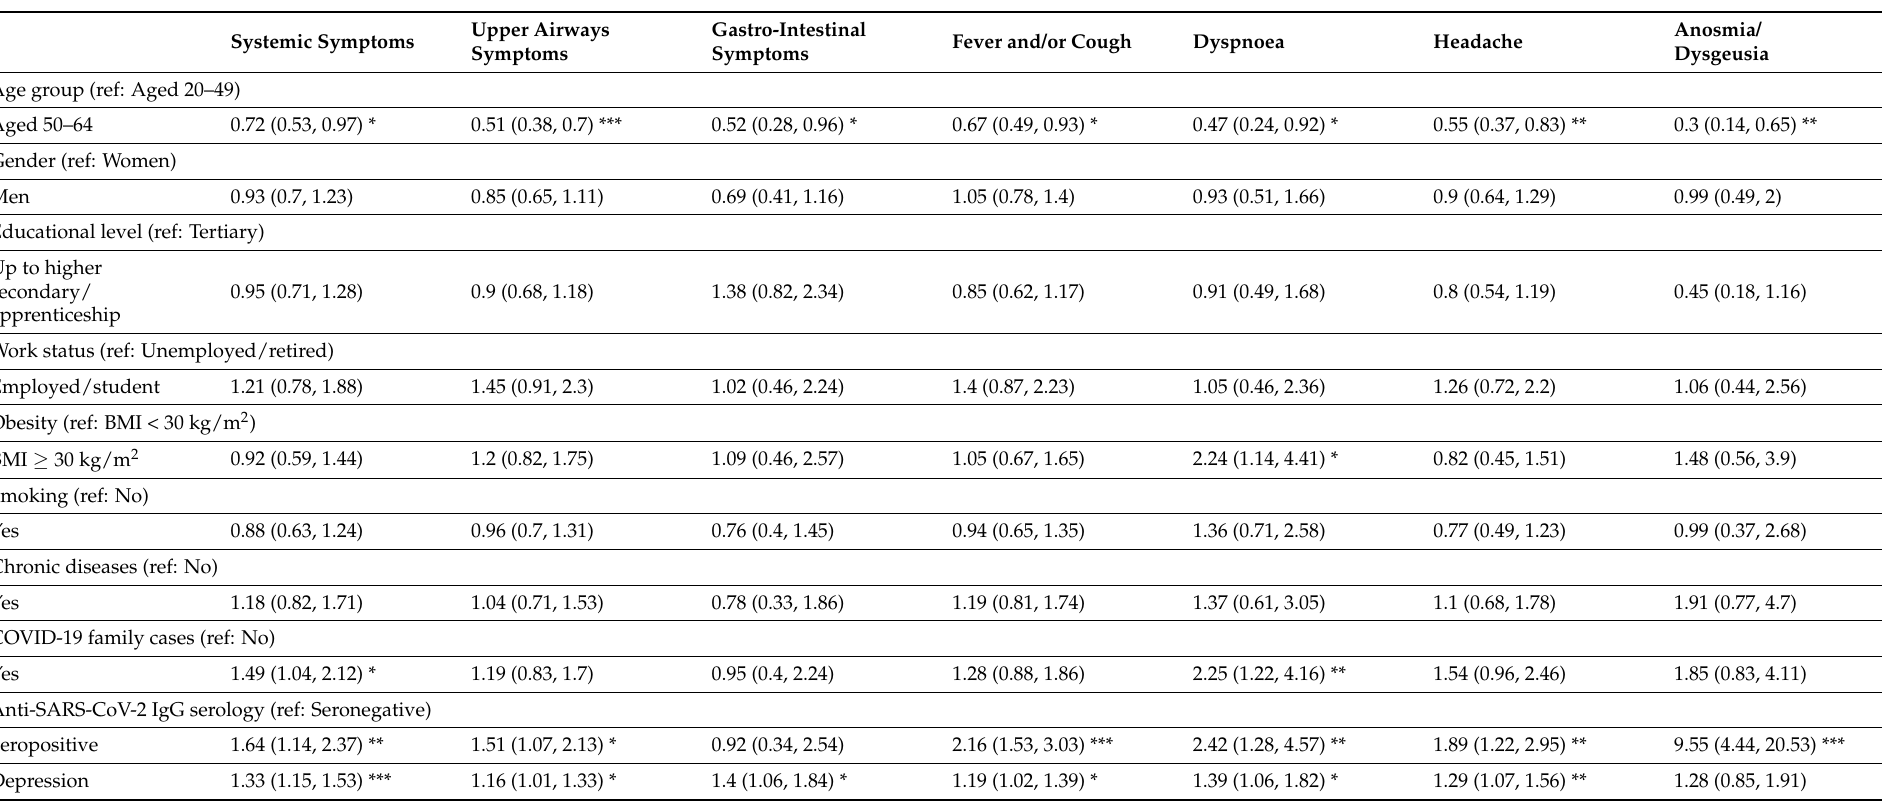
Table A5. Prevalence ratios (95% confidence intervals) from Poisson regressions estimating likelihoods of reporting COVID-19 symptoms at baseline (July 2020), Ticino (N =